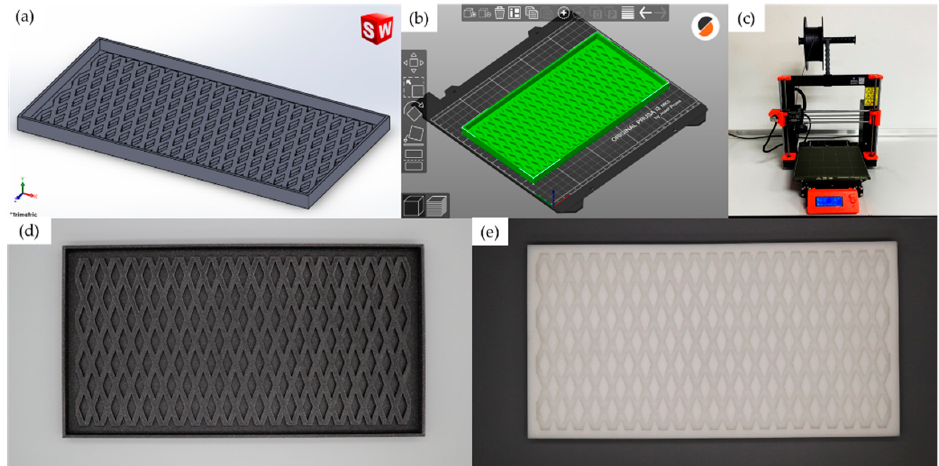
Figure 2. Schematic for fabricating a rapid silicone mold using 3D printing: ( a ) 3D model; ( b ) converting to G-code; ( c ) 3D printing; ( d ) inverted mold; and ( e ) silicone mold.